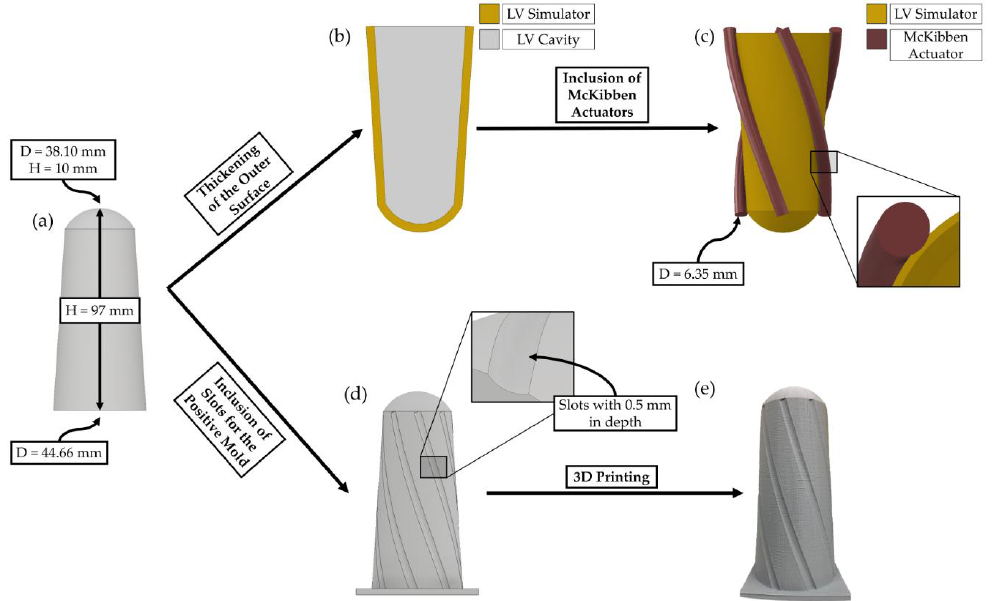
Figure 2. ( a ) Revolved solid body of the left ventricular (LV) cavity. The total height of the cavity